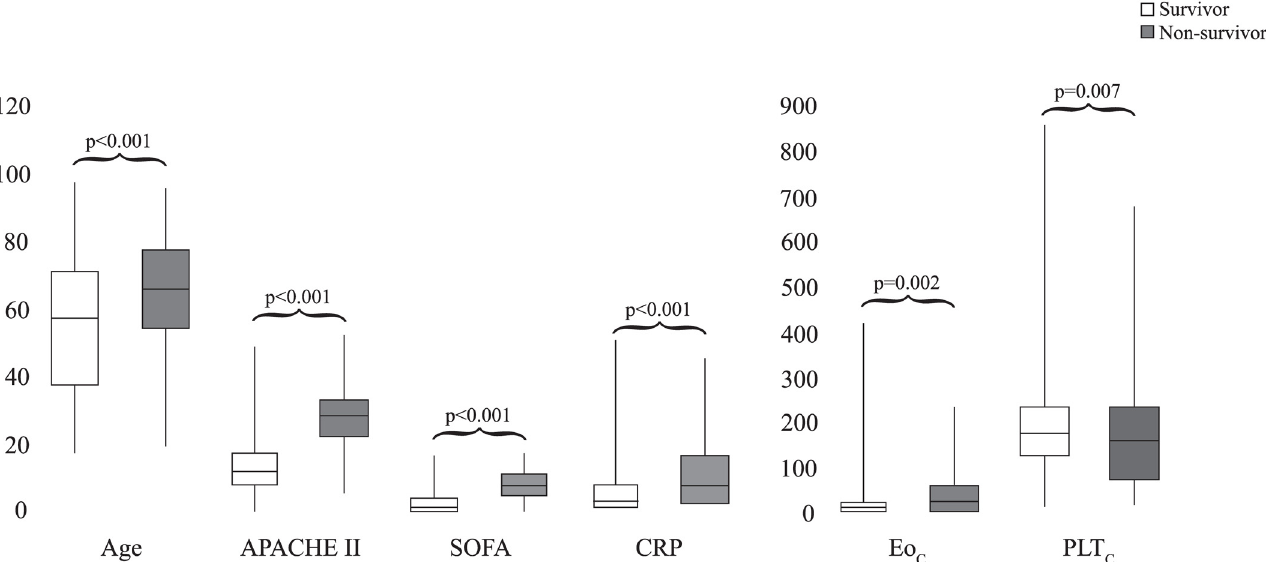
Fig 2. Comparison of survivor and non-survivor patients. Abbreviations: APACHE II, Acute Physiology And Chronic Health Evaluation; CRP, c-reactive protein; Eo C , eosinophil count; PLT C , platelet count; SOFA, Sequential Organ Failure Assessment.